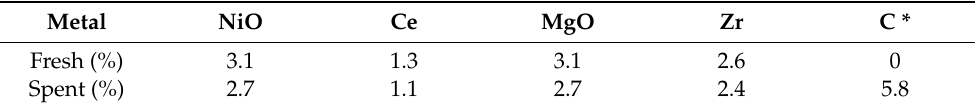
Figure 3. SEM images of ( a ) Fresh and ( b ) Spent 3 wt.% Ni/Ce-Zr-Mg/Al 2 O 3 catalysts.